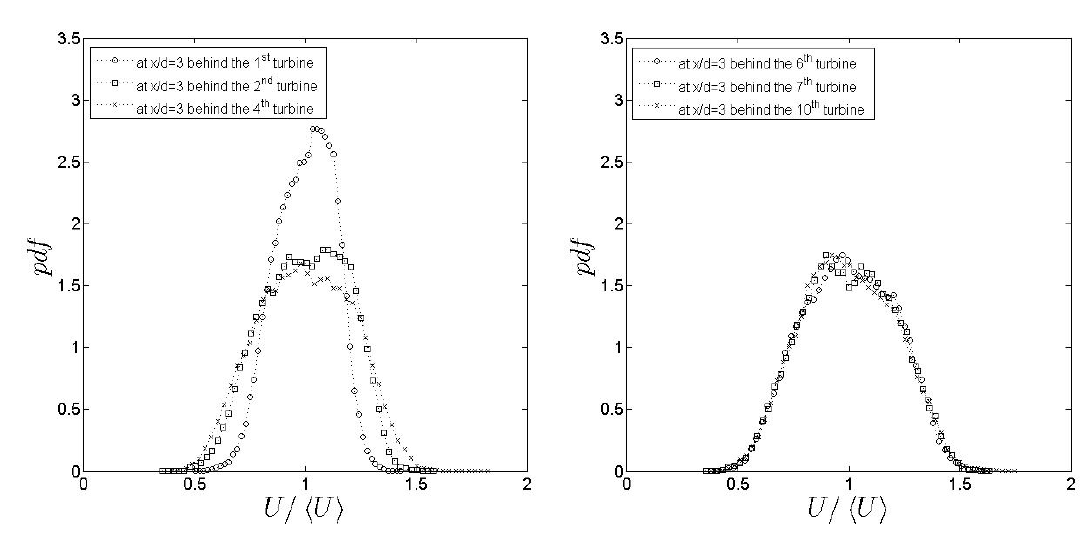
Figure 12. P.d.f. of streamwise velocity component at top tip height inside the wind farm = 5 ( S x